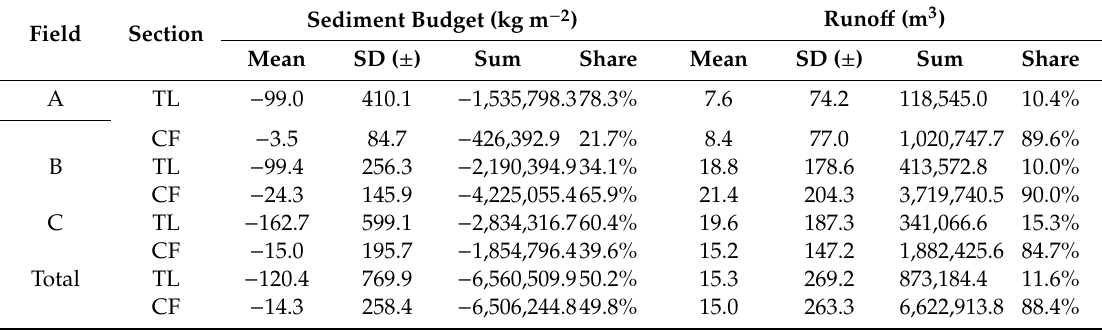
Table 3. Comparison of tramline (TL) and cultivated field (CF) section for the parameters Sediment Budget and Runo ff for di ff erent fields for 1 m resolution.